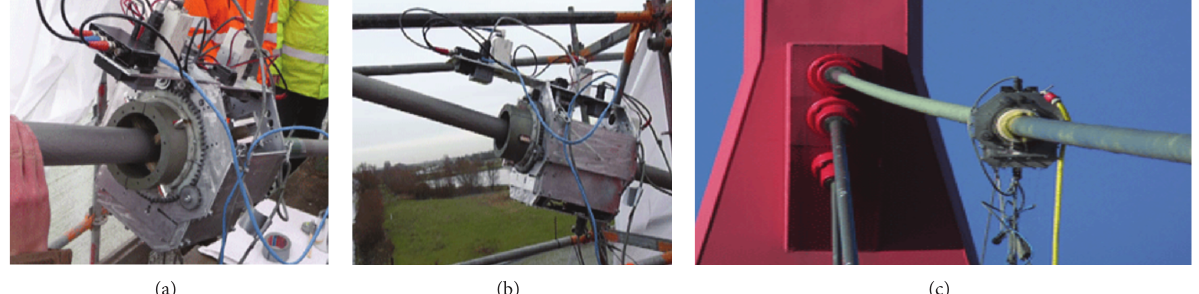
Figure 12: Mavis ReCreator and visual inspection [51].